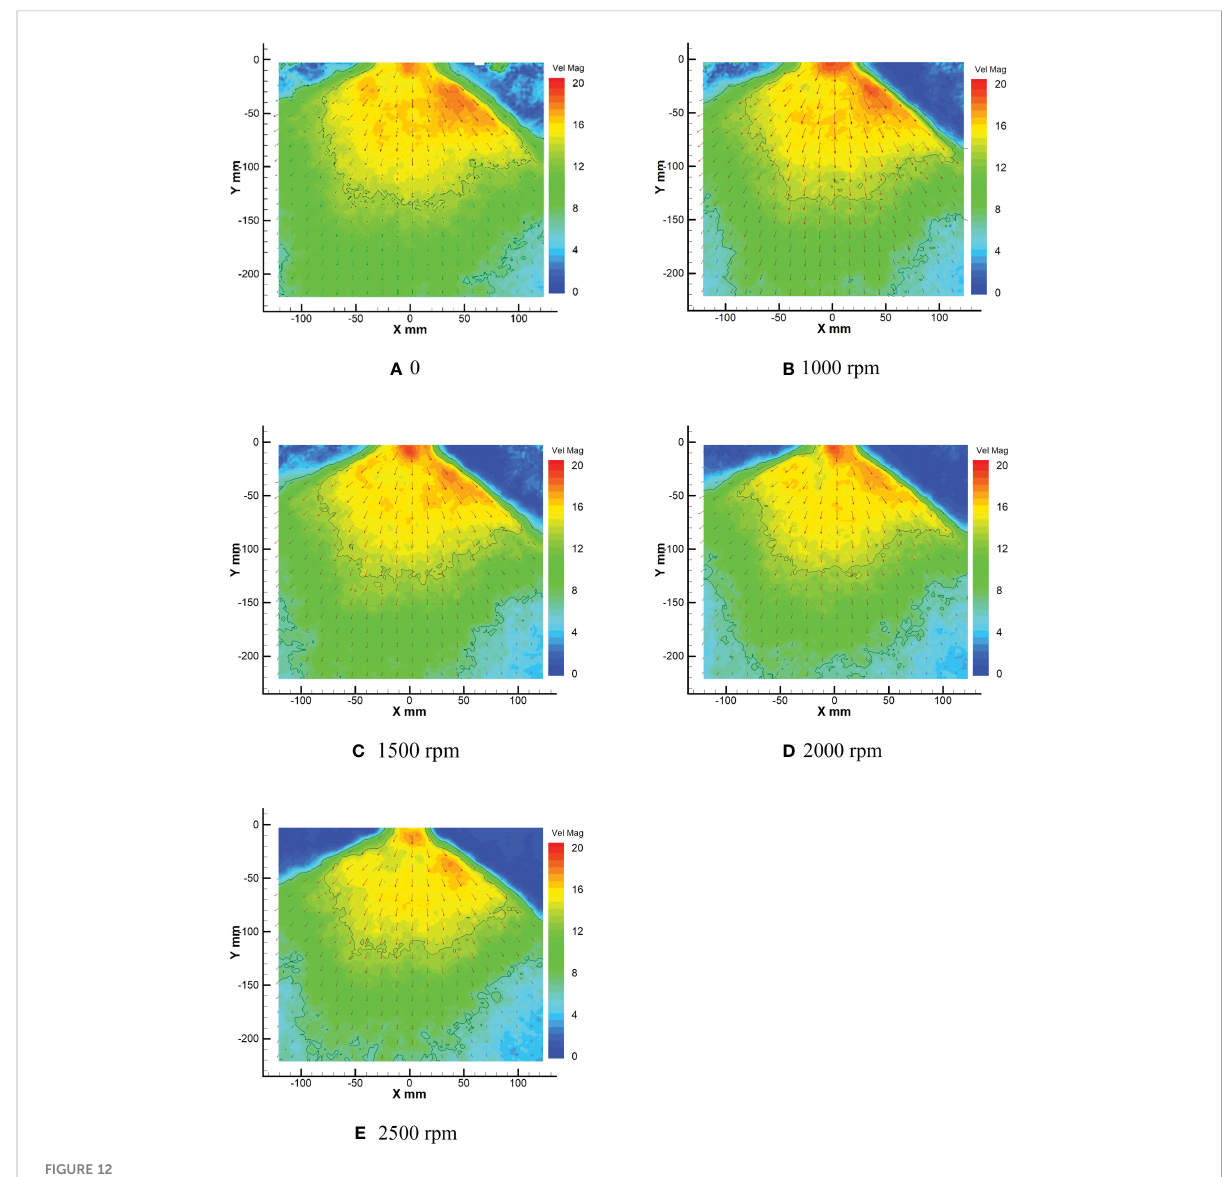
FIGURE 12 Average droplet velocity fi eld at different rotor